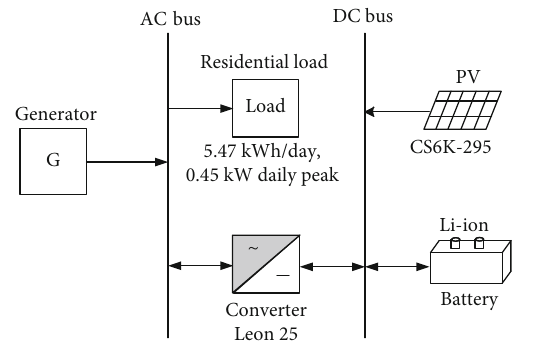
Figure 5: Layout diagram for o ff -grid power system with generator, PV, battery and converter.